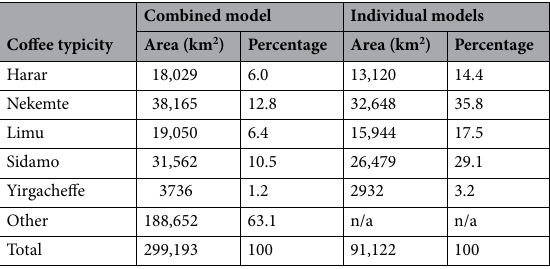
Table 1. Area and percentage suitable for growing coffee under current climatic conditions.